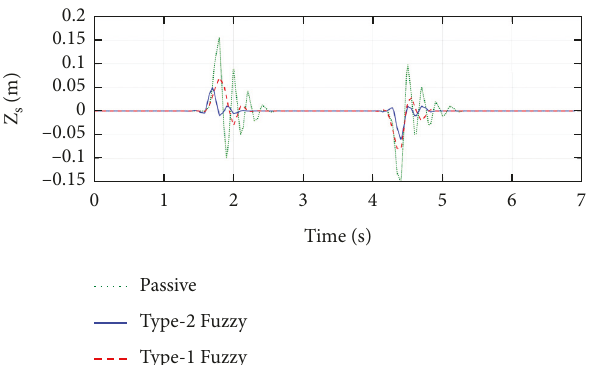
Figure 8: Body velocity.